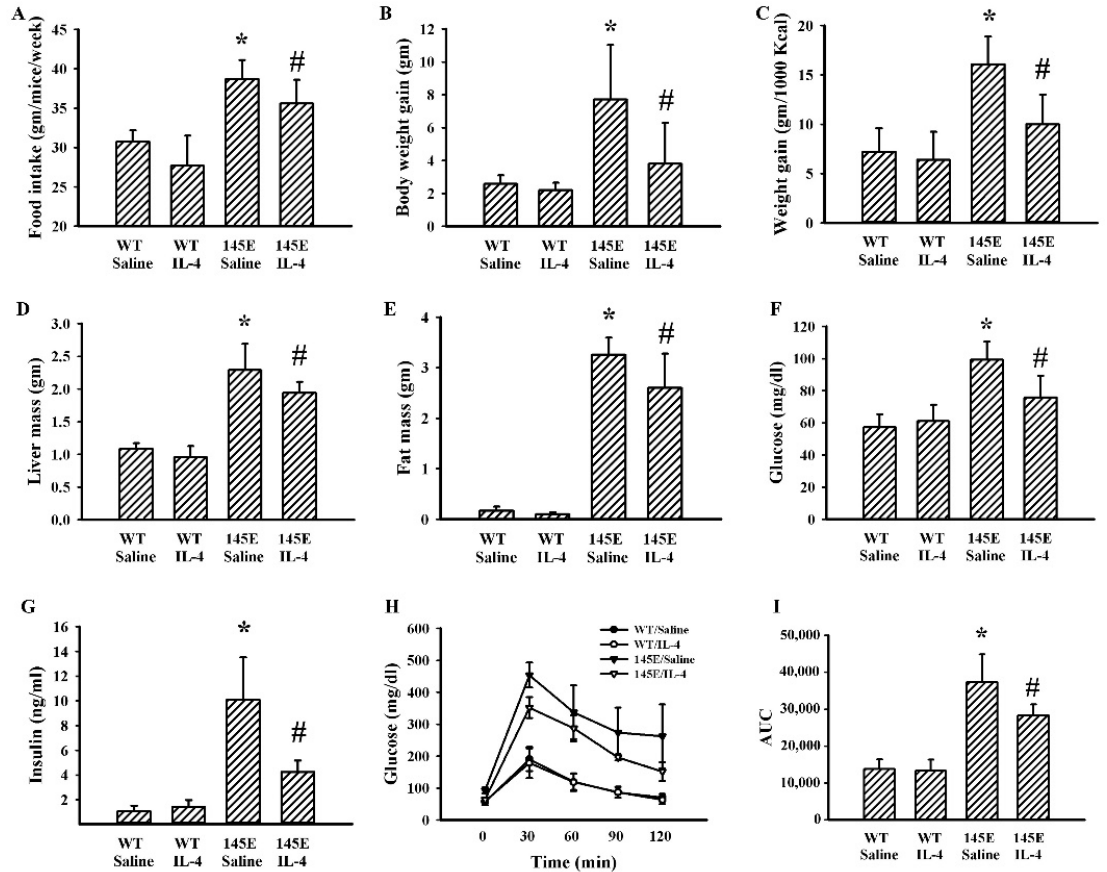
Figure 2. IL‐4 ameliorated metabolic changes in the leptin‐deficient mice. Wild type C57BL/6 (WT) and leptin‐deficient 145E mice were fed the normal diet (ND) for 8 weeks. Simultaneously, normal saline and IL‐4 (1 μg/mouse) were intraperitoneally administrated twice a week. The average food intake ( A ), body weight gain ( B ), feeding efficacy ( C ), liver mass ( D ), and epididymal fat mass ( E ) were measured. Blood samples were collected from 8‐h fasting mice and fasting glucose ( F ) and insulin ( G ) levels measured. The 8‐h fasting mice were intraperitoneally injected with a glucose solution (2 g/kg). Blood samples were collected from the tail veins at the indicated times after treatments and the levels of glucose were measured ( H ). AUC of the glucose–time curves was calculated ( I ). * p < 0.05 vs. WT/saline group and # p < 0.05 vs. 145E/saline group, n = 6.